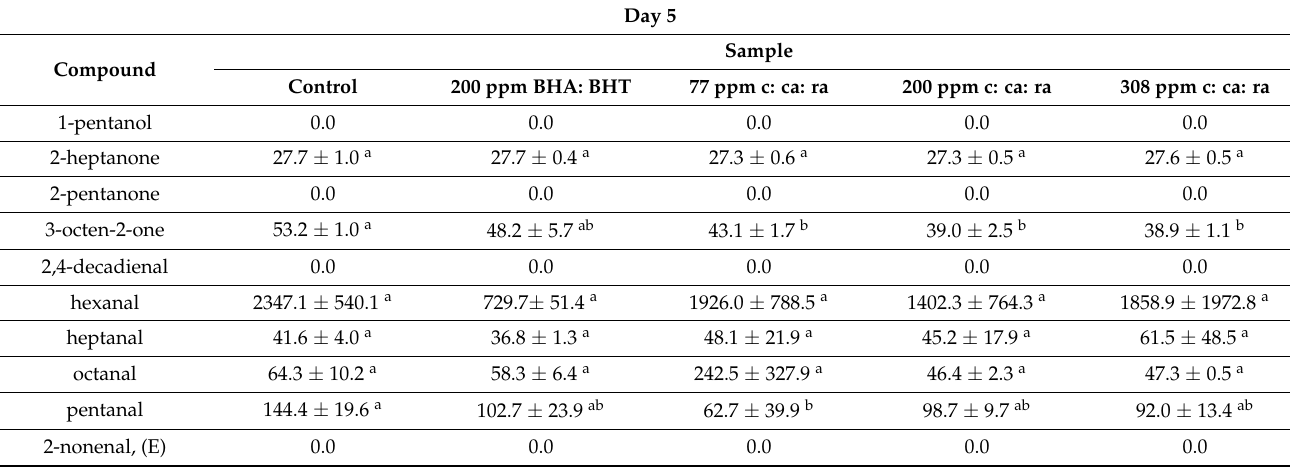
Table A5. Levels of volatile compounds ( µ g/kg of FFMP) as measured with HS-SPME-GC-MS analysis in FFMPs with or without antioxidants, after accelerated storage (40 ◦ C, RH 23%) for 5 days 1, 2, 3, 4 .